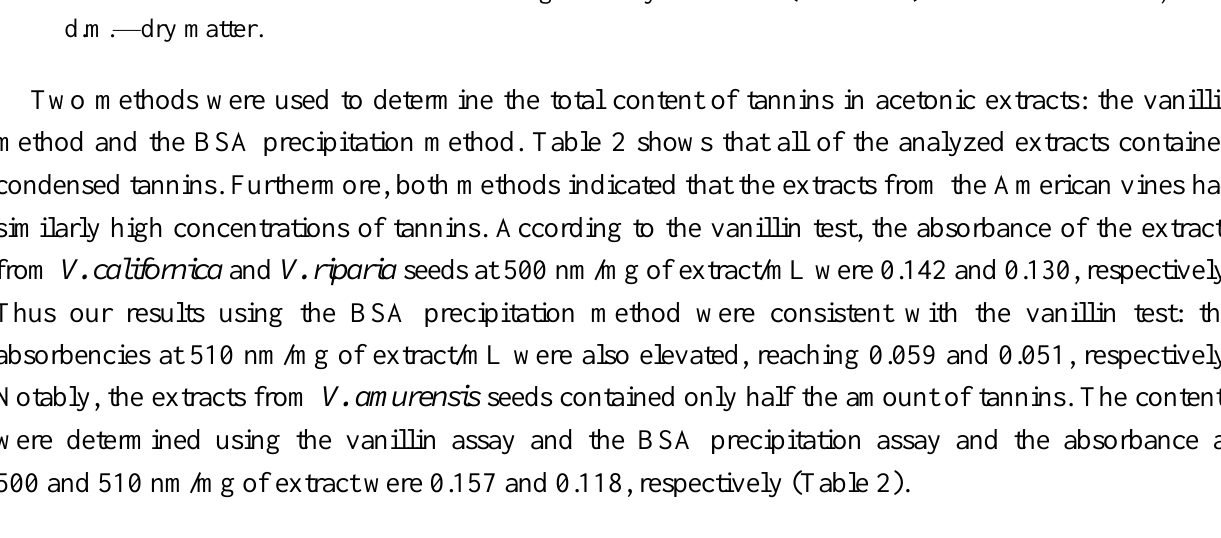
Table 2. Content of condensed tannins in the acetonic extracts expressed as absorbance at 500 and 510